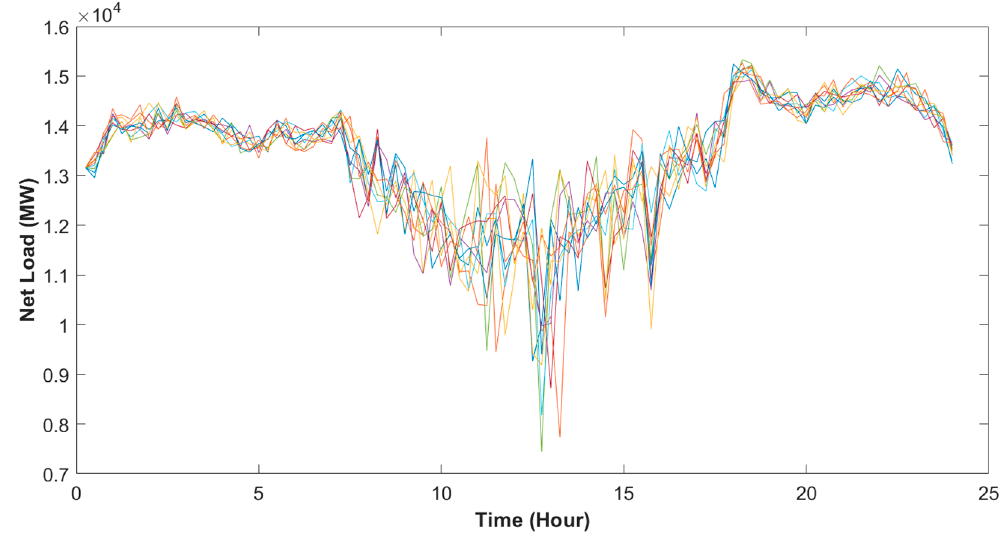
Figure 15. Renewable energy variations “low” in 10 sets of net-load scenarios in the winter.